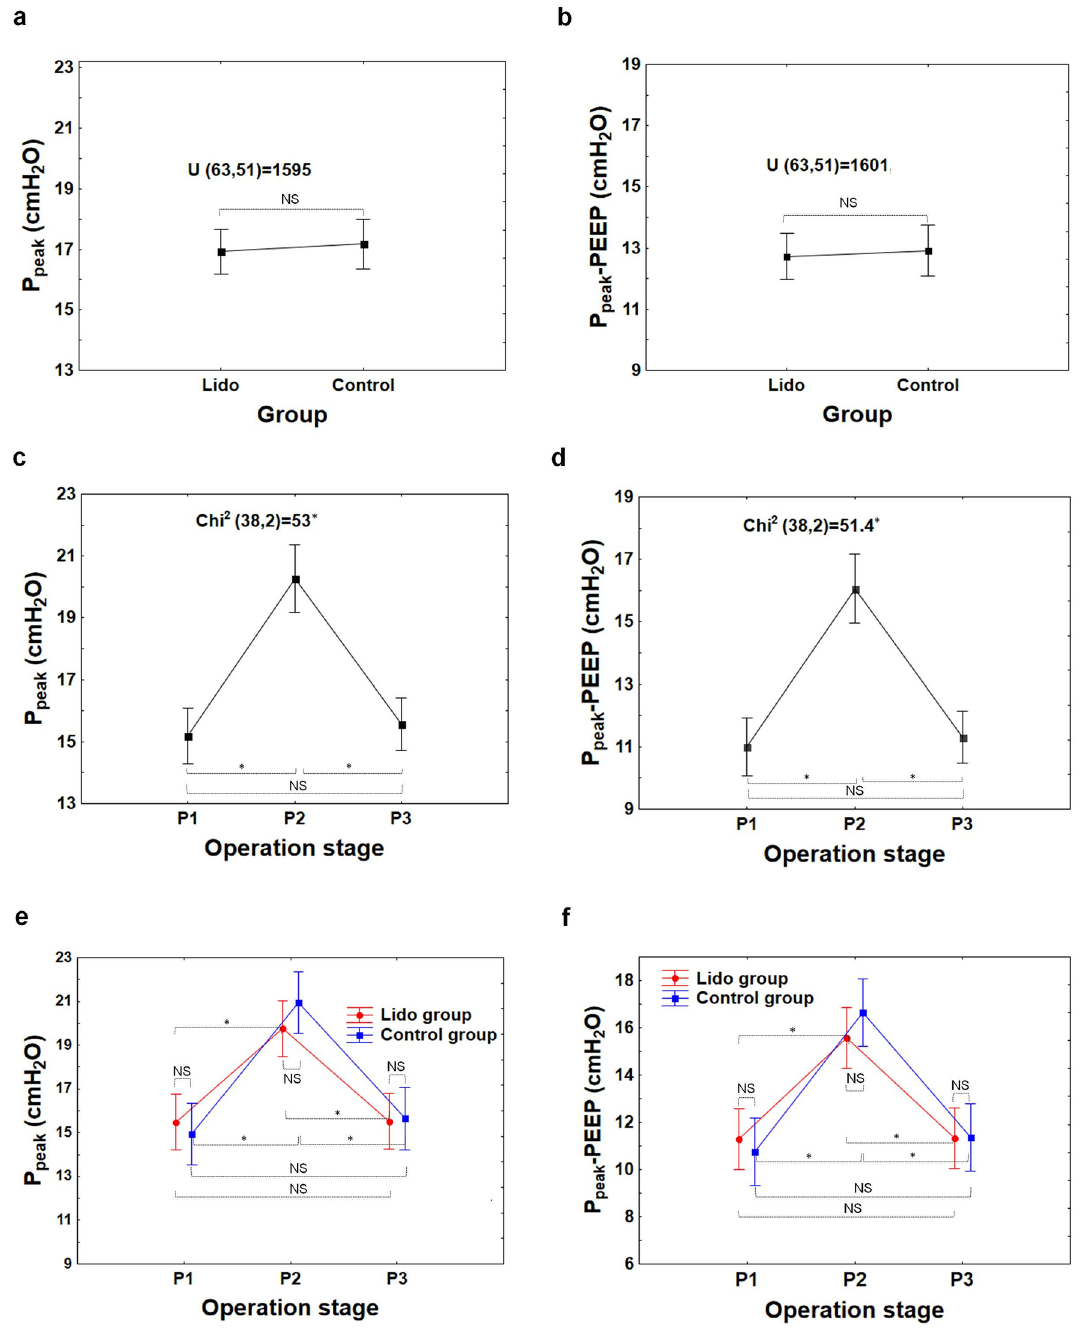
Figure 4. Peak pressure (P peak ) and the peak pressure minus positive end-expiratory pressure (P peak -PEEP) in the patient-ventilator system at the beginning (P 1 −baseline), during (P 2 ) and at the end of surgery (P 3 ) in the Lido and Control group. The differences between patients’ groups are insignificant (NS), ( a , b ). The differences between the P 1 , P 2 and P 3 stages are significant ( c , d ); *P < 0.001 (1− β = 0.99 for α = 0.001). The difference between Lido and Control group at the P 1 , P 2 and P 3 level is insignificant (NS), ( e , f